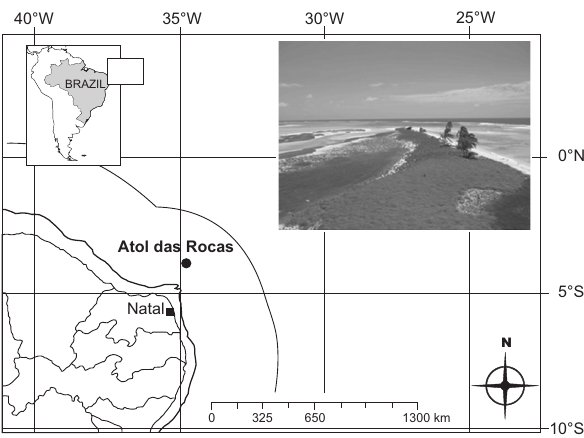
Figure 1. Location of Atol das Rocas, Rio Grande do Norte,